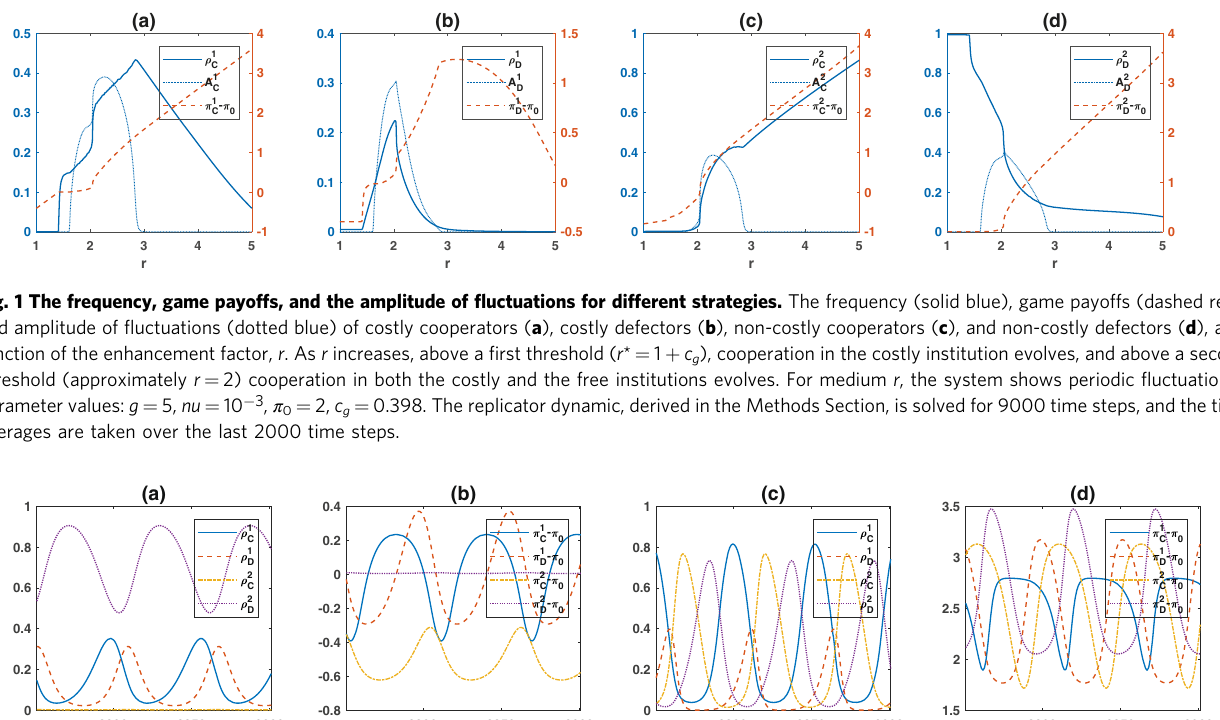
color plotted as well (see Supplementary Fig. 1 for the frequency of different strategies). Red dashed lines show the boundary of the region where the system settles in a periodic orbit. For high costs, as r increases, the system shows a series of successive cross-overs from a defective fi xed point to the red queen periodic orbit, black queen periodic orbit, and fi nally a cooperative fi xed point. On the other hand, for small costs, the system possesses a bistable region where both the red queen and black queen periodic orbits (or a partially cooperative fi xed point and black queen periodic orbit to the left of the red dashed line in the bistable region) are stable, and the system shows a discontinuous transition between these two orbits. Orange circles show the lower boundary of the bistable region, below which the black queen orbit is unstable. Its upper boundary, above which the red queen orbit becomes unstable, is plotted by red squares, in Fig. 3. The transition between the two periodic orbits becomes a continuous transition at a single critical point (see Supplementary Fig. 4).